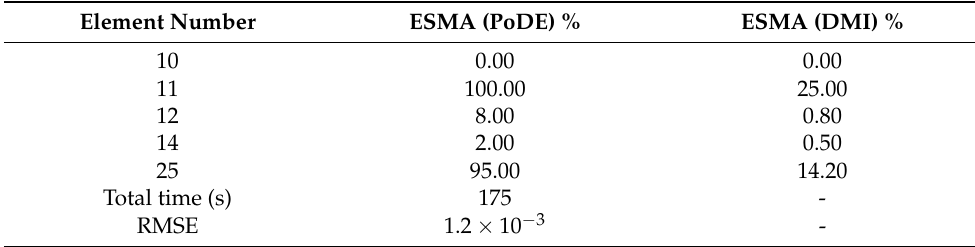
Table 4. PoDEs and DMIs of case 2 for the 31-bar planar truss.